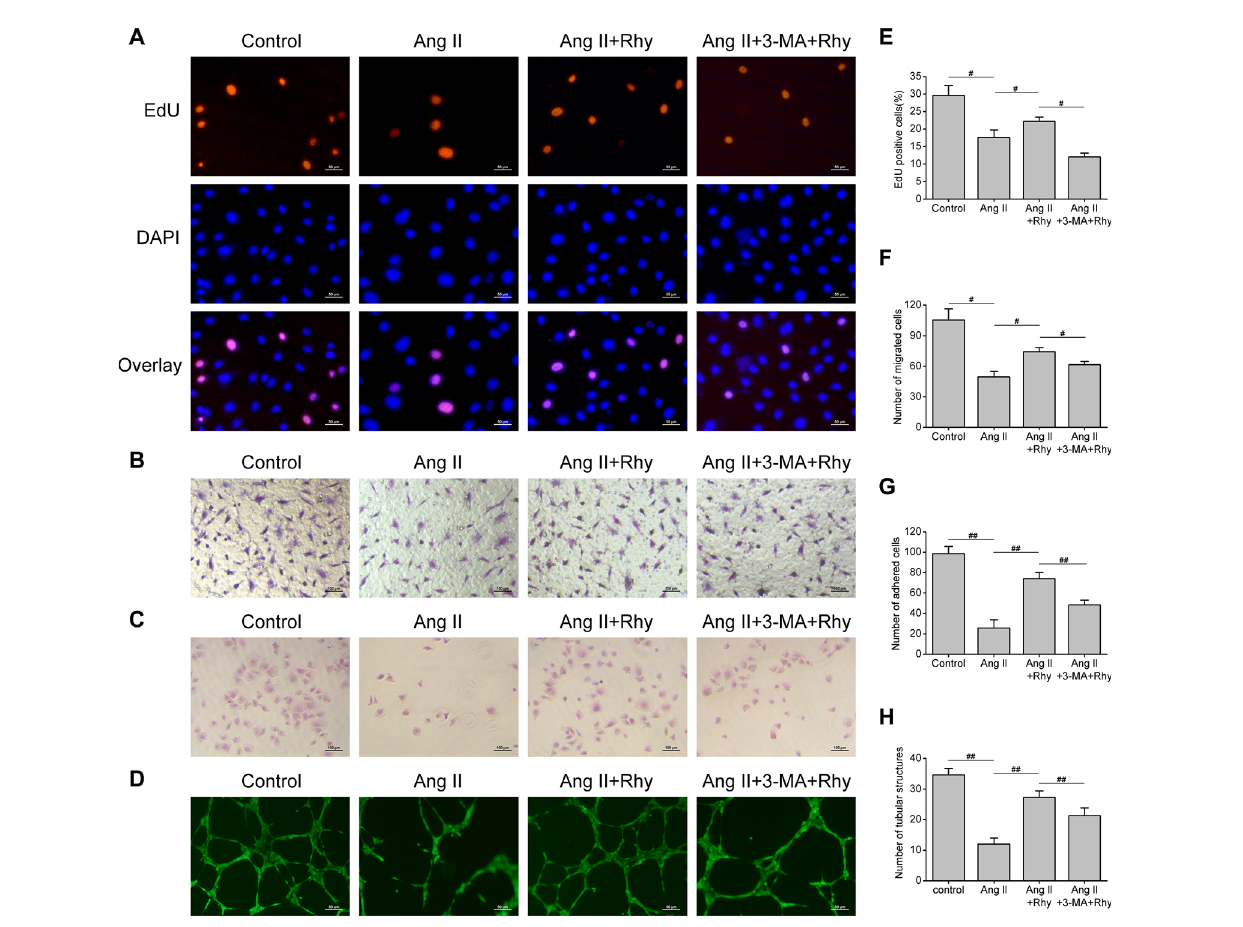
FIGURE 5 | Rhynchophylline improved EPCs function. (A, E) Representative images and quantitative analysis of proliferative activity assay (200× magni fi cation). (B, F) Representative images and quantitative analysis of migration assay (H&E stain, 100× magni fi cation). (C, G) Representative images and quantitative analysis of adhesion assay (H&E stain, 100× magni fi cation). (D, H) Representative images and quantitative analysis of network formation assay in vitro (200× magni fi cation). The number of tubular structures in the fi eld represented the angiogenesis capacity of EPCs. All data were pooled as mean ± S.D. (error bars) from three independent biological repeats experiments, each of which included 3 technical repeats. # P < 0.05; ## P <